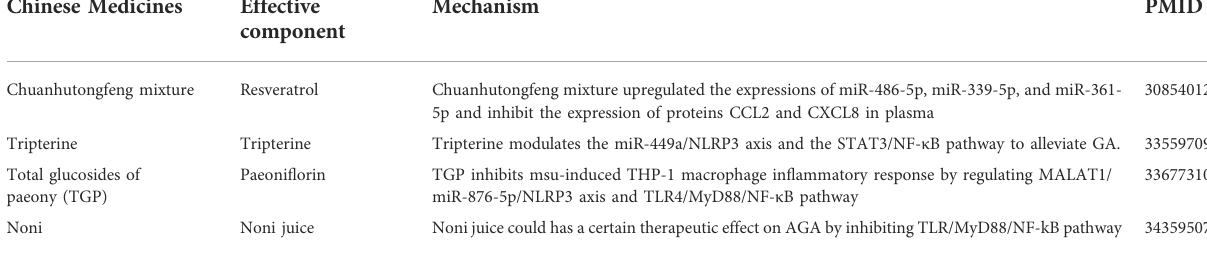
TABLE 2 The mechanism of microRNA in the treatment of GA with traditional Chinese medicine. Chinese Medicines Effective